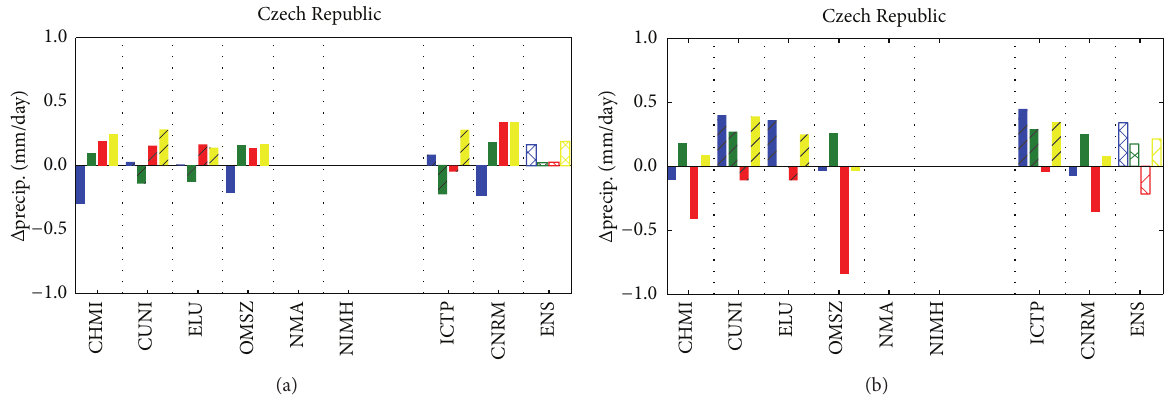
Figure 10: Change in total precipitation over Czech Republic between 2021–2050 and 1961–1990 (a) and 2071–2100 and 1961–1990 (b); blue = DJF, green = MAM, red = JJA, yellow = SON, hatched = RegCM-ECHAM couple, plain = Aladin-Arpege couple, and ENS = average of 14 ENSEMBLES